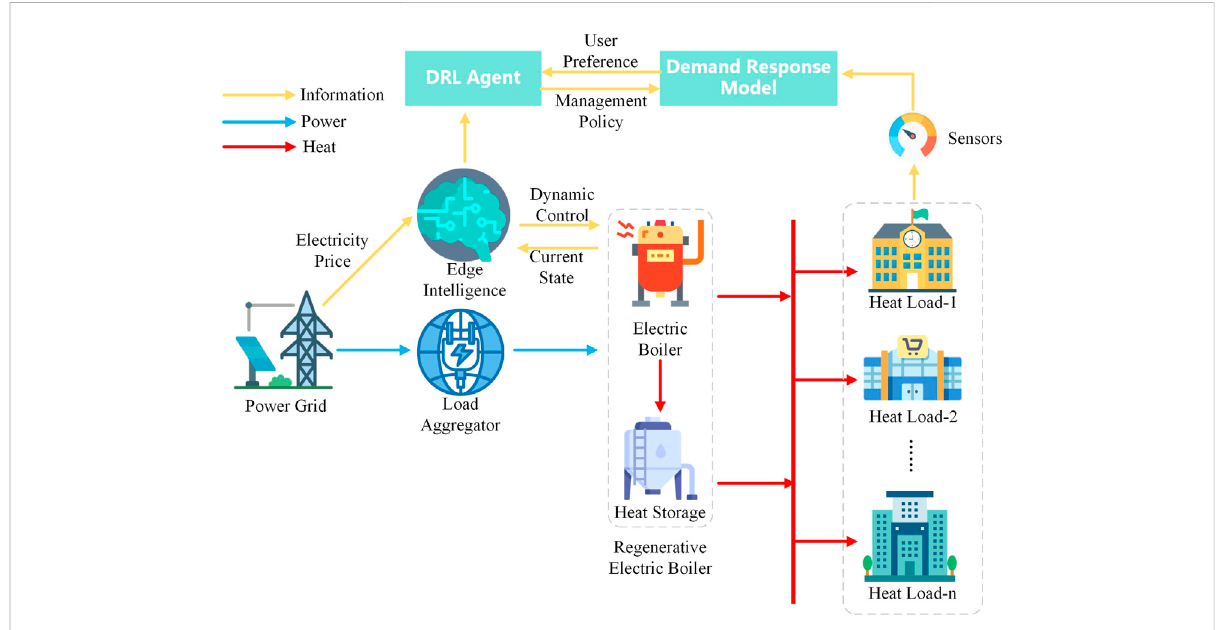
FIGURE 1 Distributed heating system